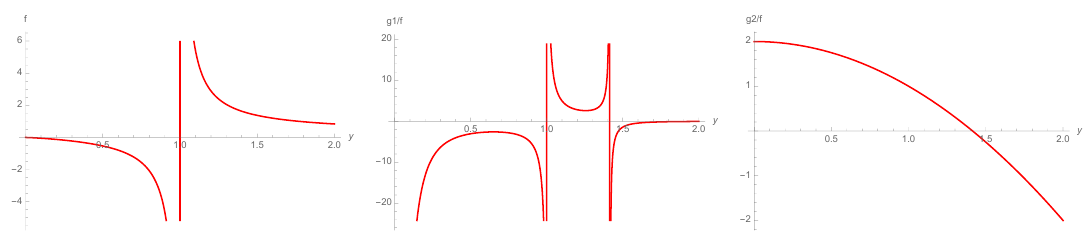
Figure 3 . A representative solution with b = − 2 and C = 1 . The solution is regular in the range of 1 < y < y = 1 . 4142 1